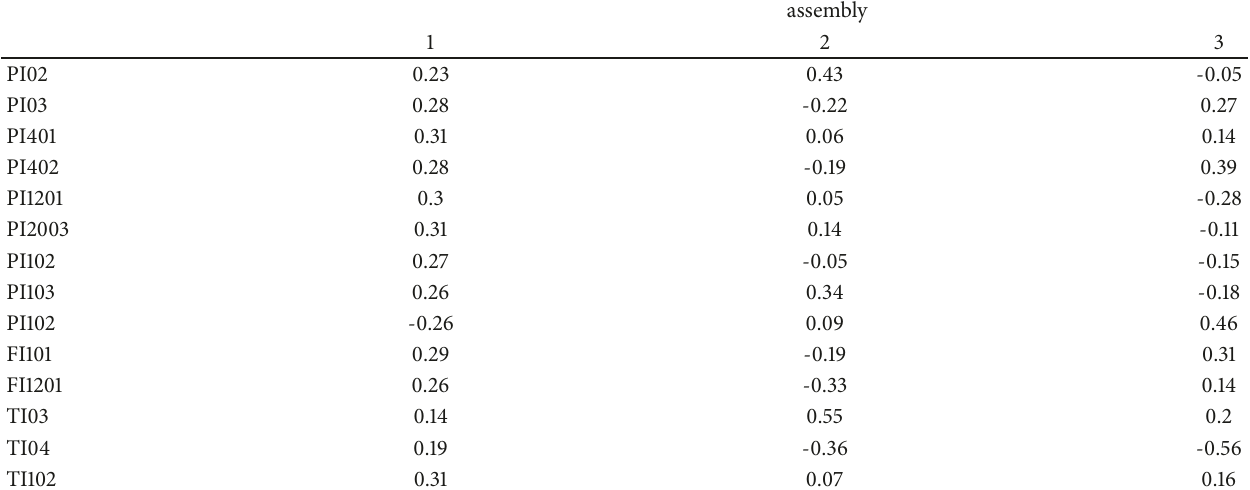
Table 7: Load matrix of the principal